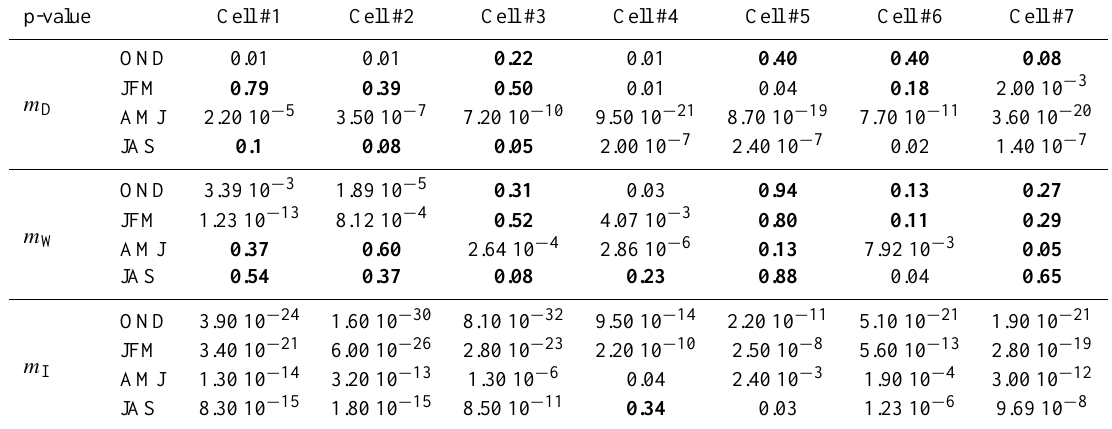
Table 2. P-value results of the Wilconox rank sum test for the difference of means between observed and RCM data (reference period 1961–1990) at a 95% confidence level. Bold characters are used to remark the passed